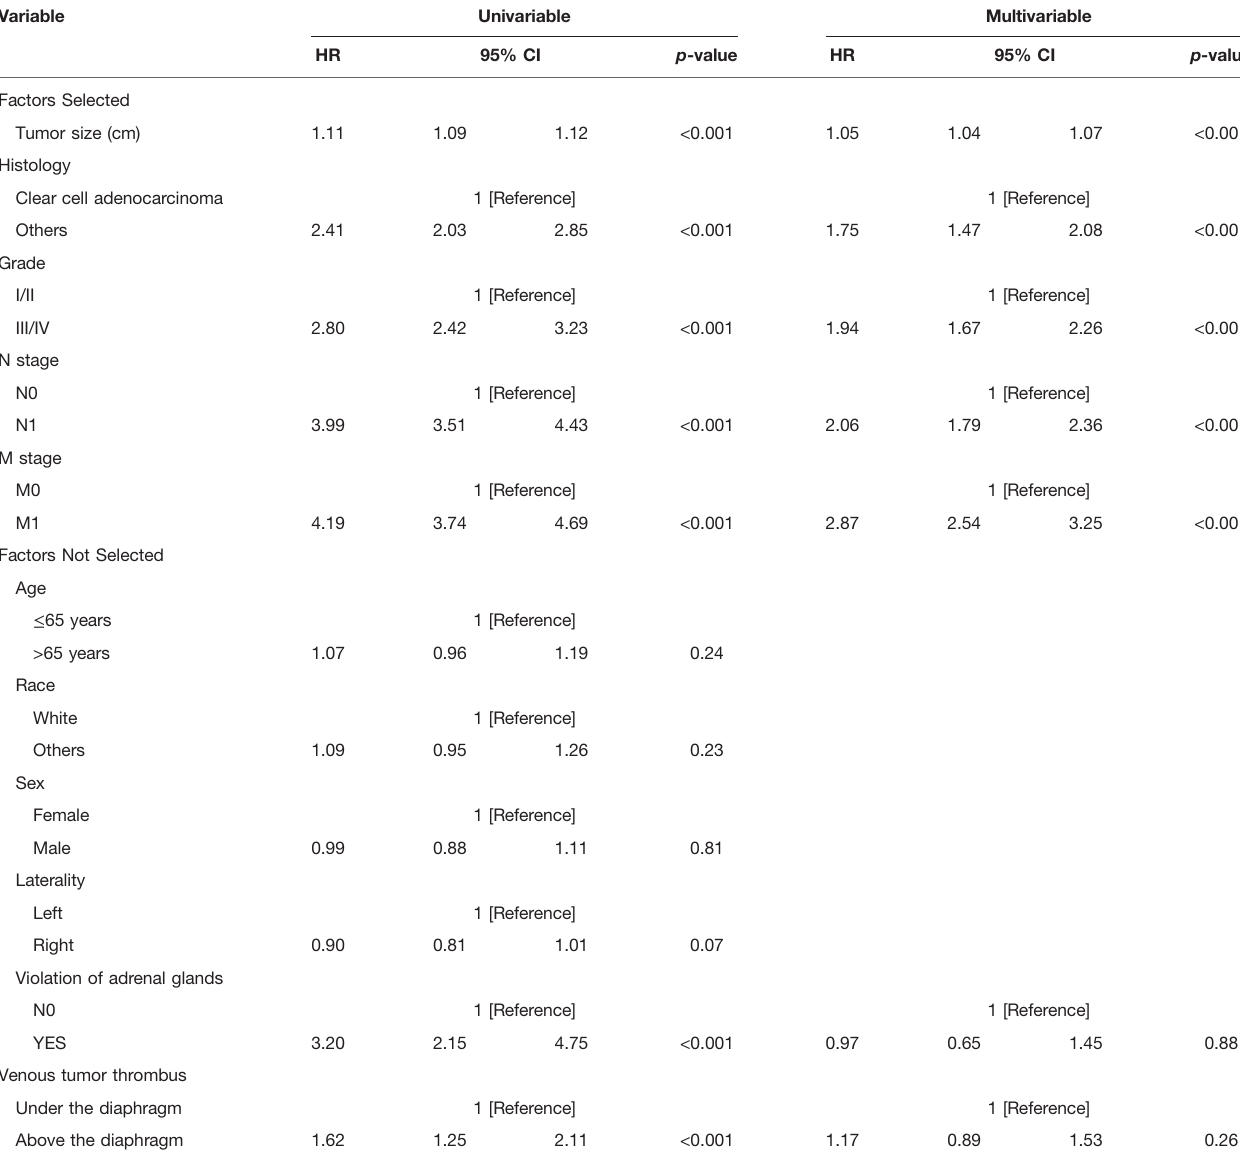
TABLE 2 | Cox proportional hazards regression model showing the association of variables with cancer-speci fi c survival.